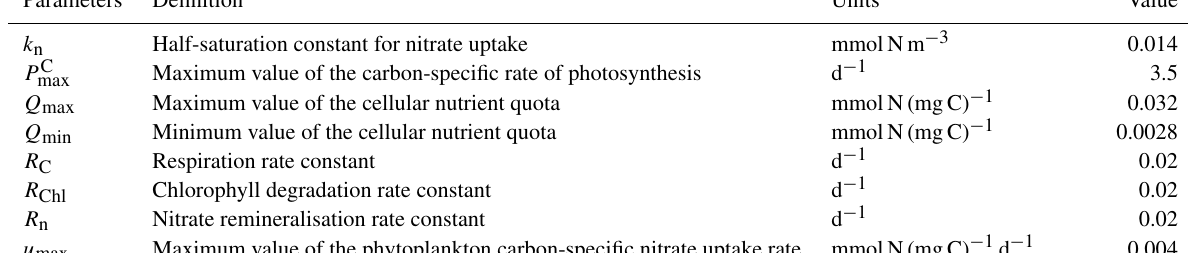
Table A2. List of parameters, with their respective definitions, units, and initialised values for the biological part of the S2P3 v8.0 model.